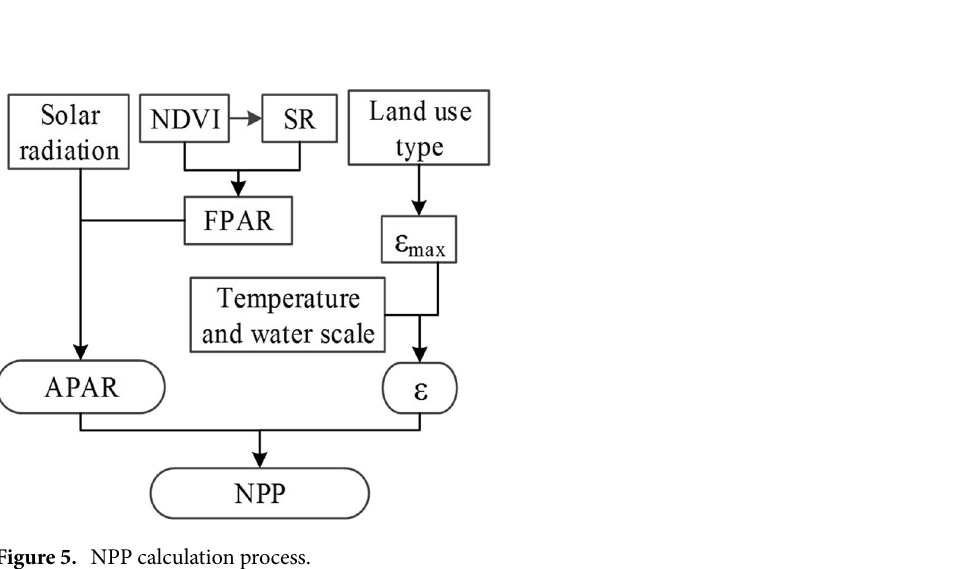
Table 2. Maximum LUE rates of different land use types.